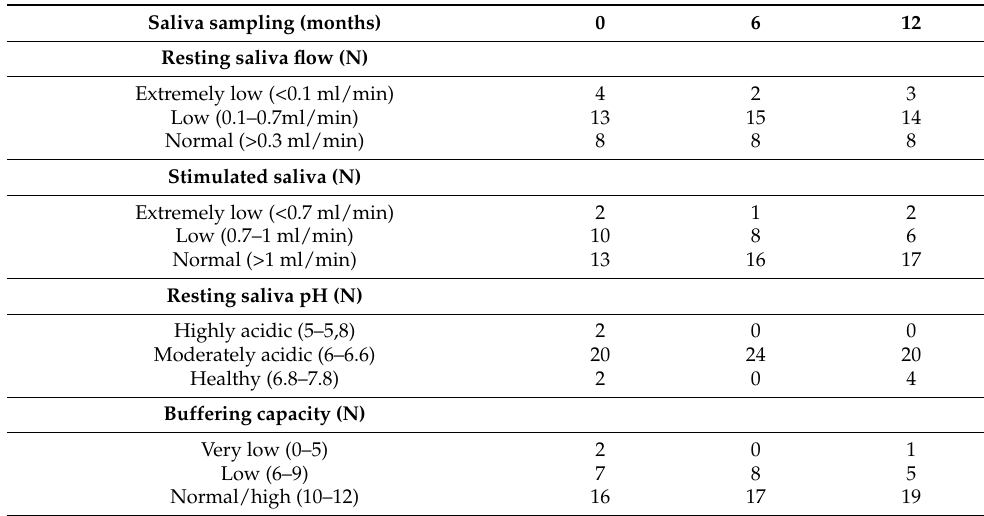
Figure 2. The boxplots of the salivary parameters ( A ) resting saliva, ( B ) resting saliva pH, ( C ) stimu- lated saliva, ( D ) buffering capacity, and ( E ) subjective dry mouth sensations for 3 time points of 0, 6, and 12 months (n = 21). The omnibus analysis of these parameters at three timepoints was conducted with Friedman’s test and pairwise post hoc analysis with Bonferroni corrected Wilcoxon signed-rank tests. The boxplots show the median, mean (x), quartiles, and extreme values (o). Table 3. Frequencies of participants in each classification of variables during the